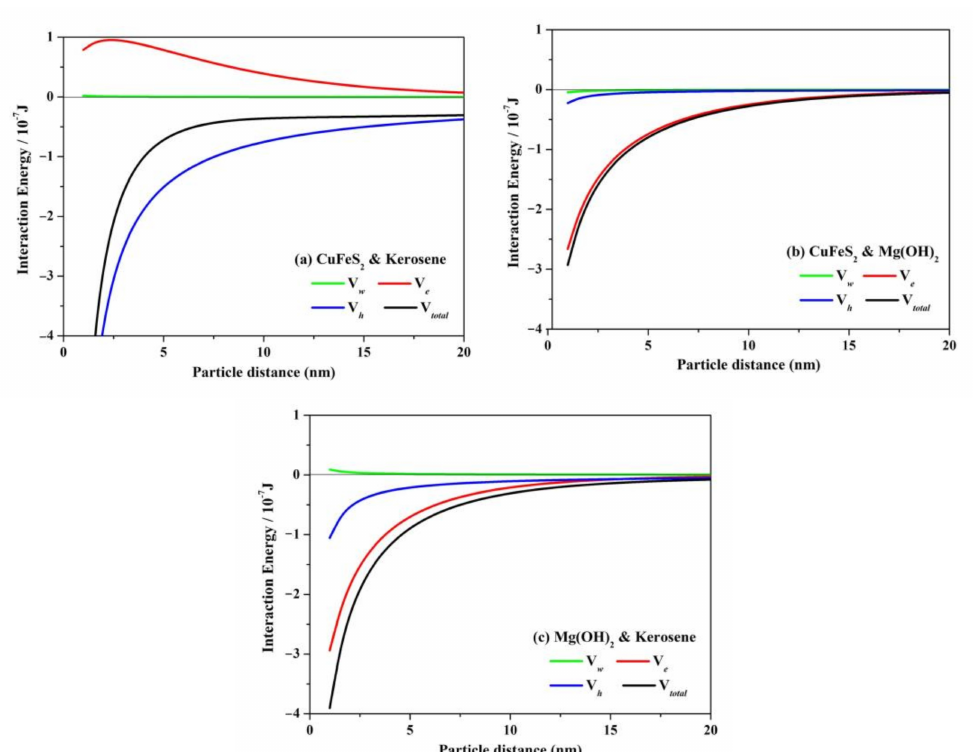
Figure 8. Interaction energy as a function of distance between ( a ) chalcopyrite and kerosene, ( b ) chalcopyrite and Mg(OH) 2, and ( c ) Mg(OH) 2 and kerosene at pH = 10, in pure water.